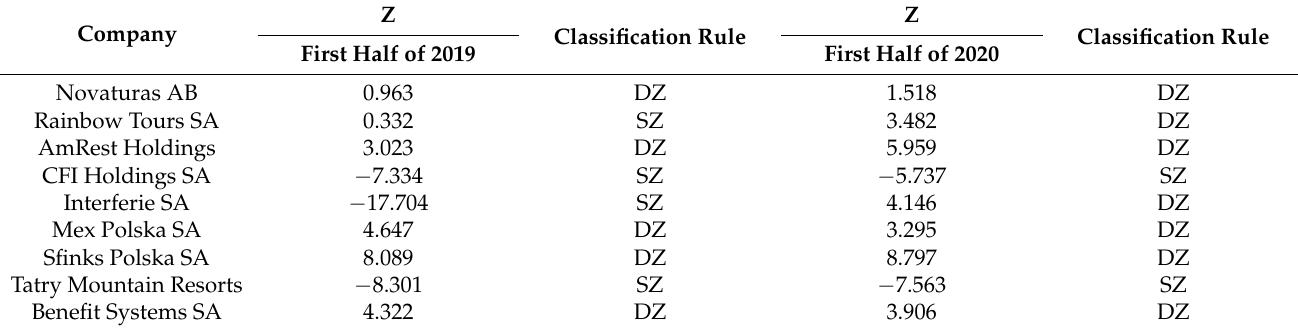
Table 5. Values and interpretation in the W˛edzki logit